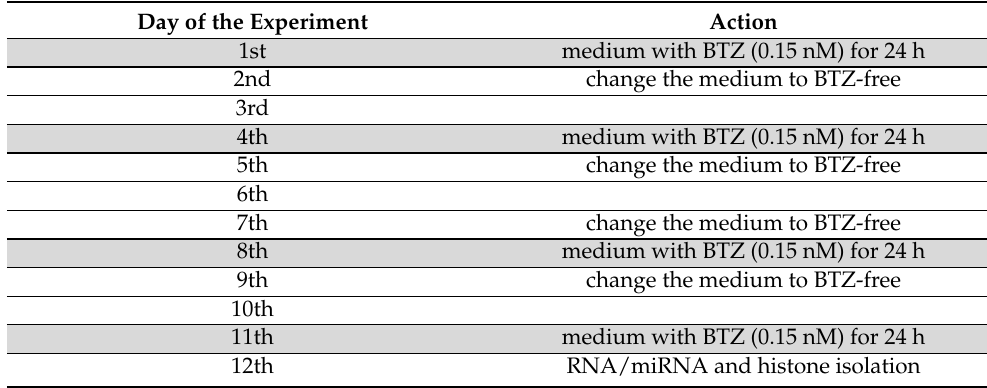
Table 1. Schedule of BTZ treatment of dLUHMES